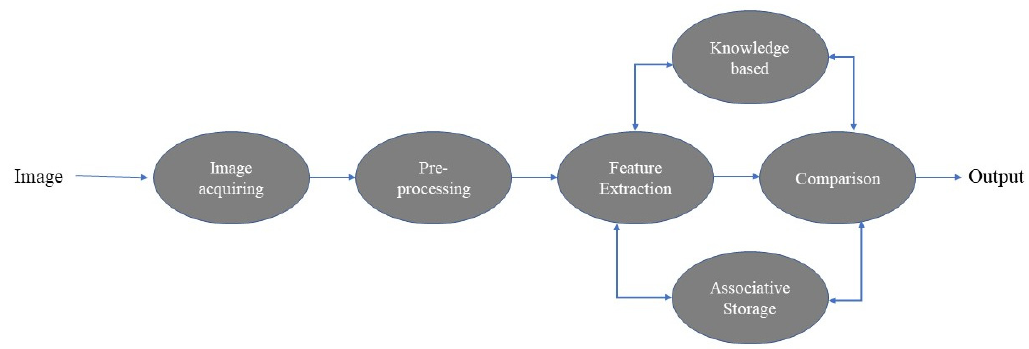
Figure 9. Flowchart of our algorithm for characterizing real or experimental microstructures using their two perpendicular images.